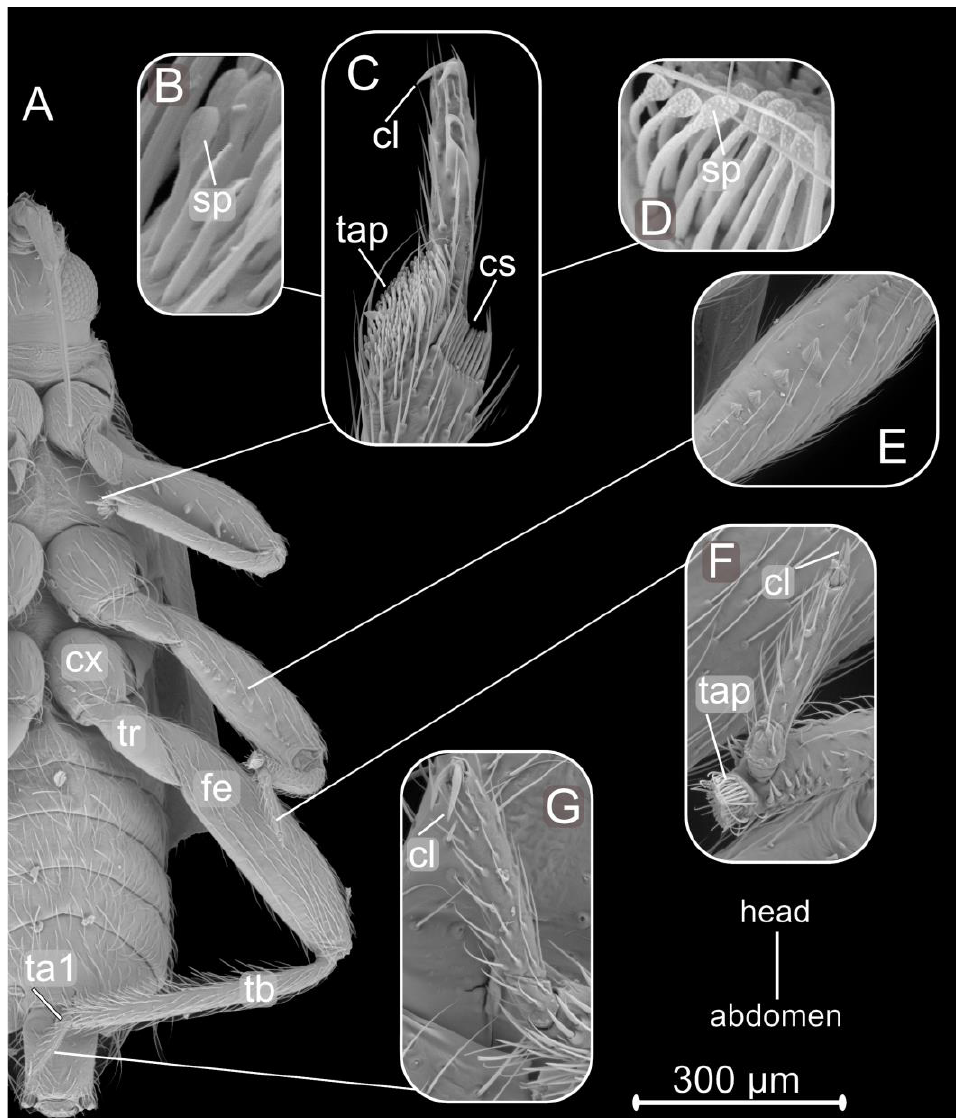
Figure 4. SEM micrograph of Embiophila myersi, adult. ( A ) Head, thorax, legs and abdomen ventral view. ( B ) Ventral view of the spatula of the tibial adhesive pad. ( C ) Apical part of the prothoracic leg showing claws, cleaning structure and the tibial adhesive pad. ( D ) Dorsal view of the spatulae with corrugated surface. ( E ) Row of spines (raptorial) on the mesothoracic femur. ( F ) Apical part of the mesothoracic leg showing claws and tibial adhesive pad. ( G ) Apical part of the metathoracic leg showing the claws. Abbreviation: cl — claw; cx — coxa; cs — cleaning structure; fe — femur; sp — spatula: ta — tarsomere; tap — tibial adhesive pad; tb — tibia; tr — trochanter.